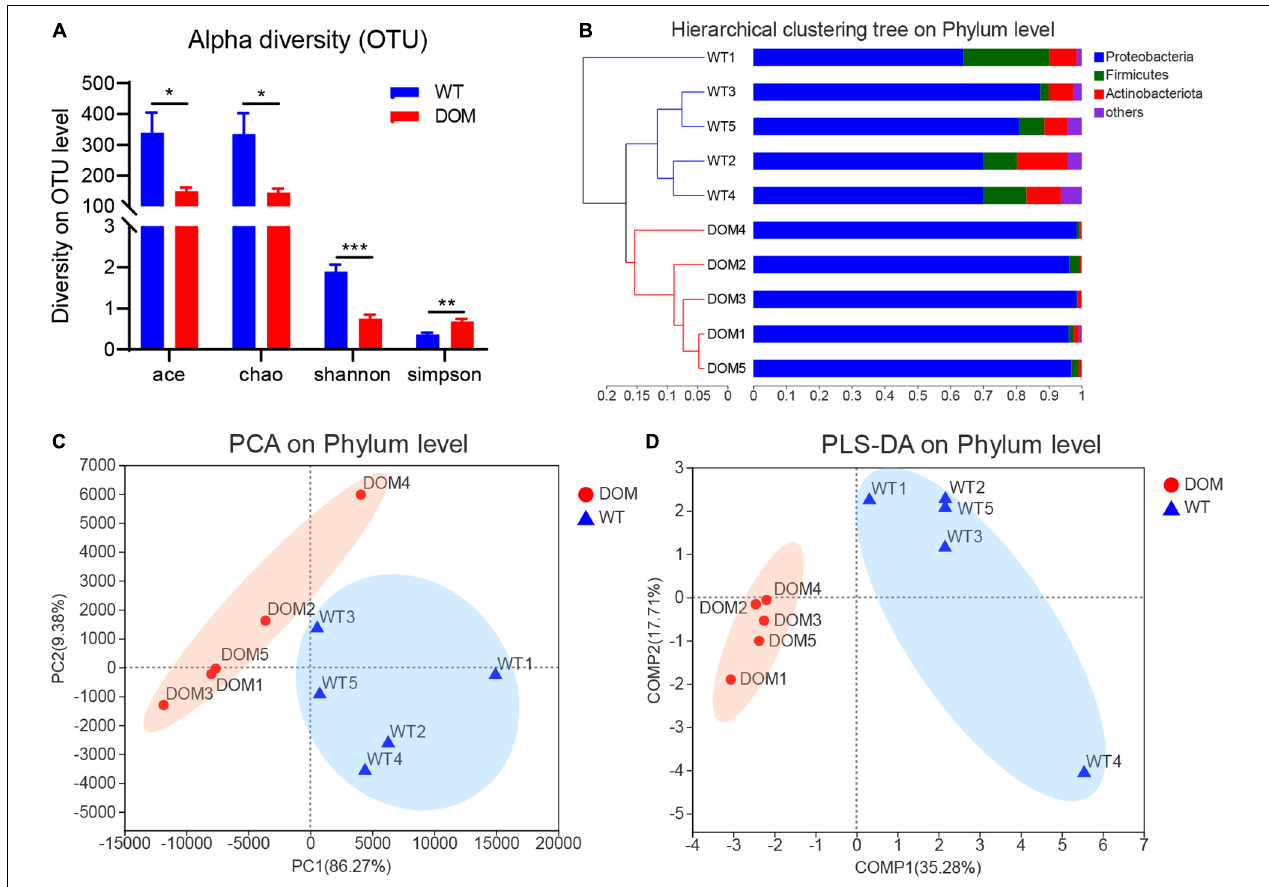
FIGURE 4 | Microbial composition of A. grunniens intestine domesticated with compound feed. (A) Alpha density of the operational taxonomic units (OTUs); (B) Hierarchical cluster at phylum level; (C) , Principal coordinates analysis (PCA) at the phylum level; and (D) Partial least-squares discriminant analysis (PLS-DA) at the phylum level. * represent P < 0.05; ** represent P < 0.01; and *** represent P <